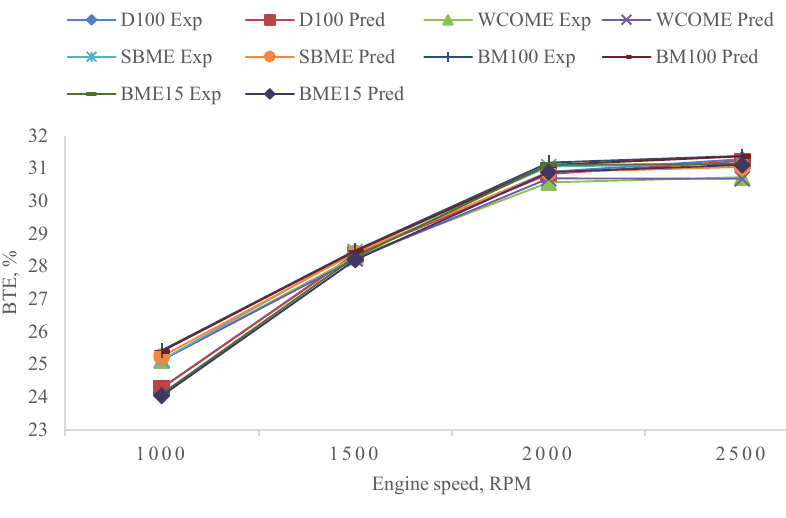
Fig. 4. Variation of brake thermal efficiency with engine speed.